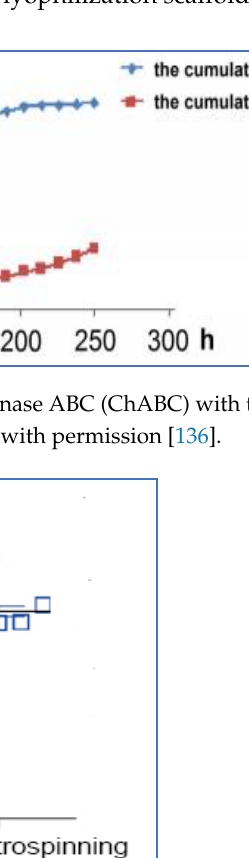
Figure 7. Comparison of the proliferation rate of Schwann cells on the electrospun chitosan scaf- fold vs. lyophilized chitosan scaffold. Adapted with permission [137].